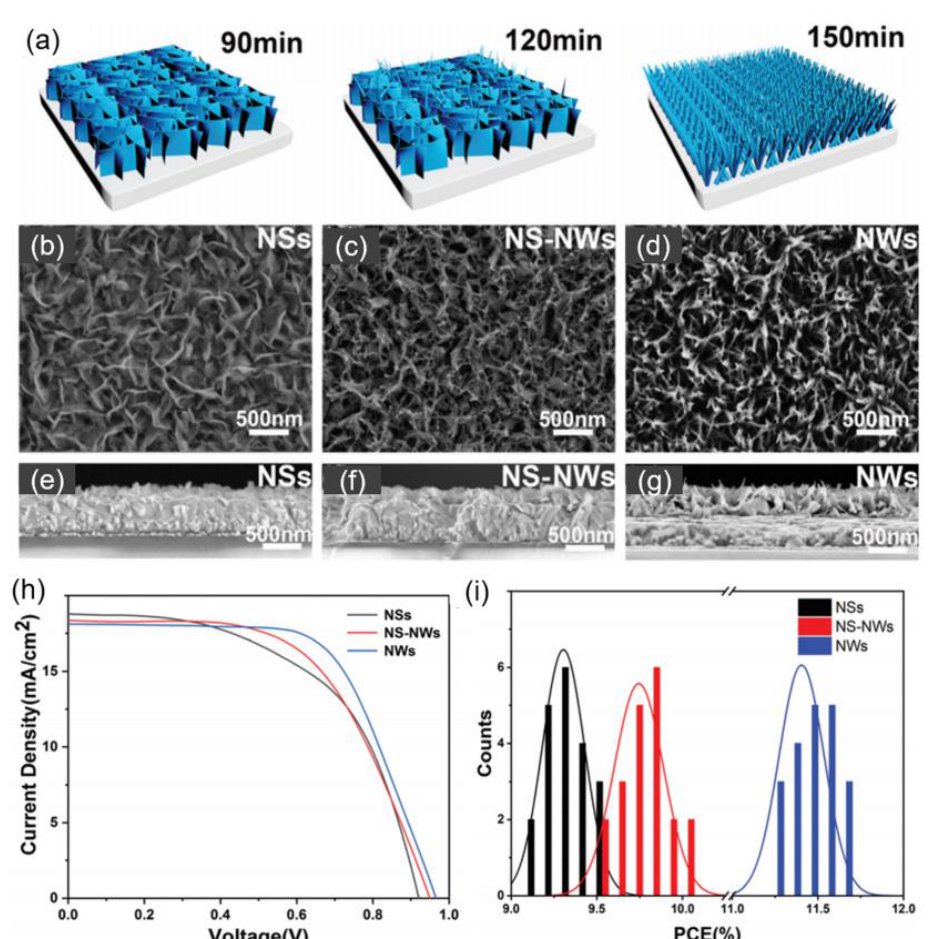
Figure 10. ( a ) Schematic diagrams of the fabrication of NiCo 2 O 4 HTL with various morphologies at different reaction time; top − view and cross − sectional SEM images of ( b , e ) NiCo 2 O 4 NSs, ( c , f ) Ni- Co 2 O 4 NSs − NWs, ( d , g ) NiCo 2 O 4 NWs; ( h ) J – V curves and ( i ) PCE histograms of PSCs with NiCo 2 O